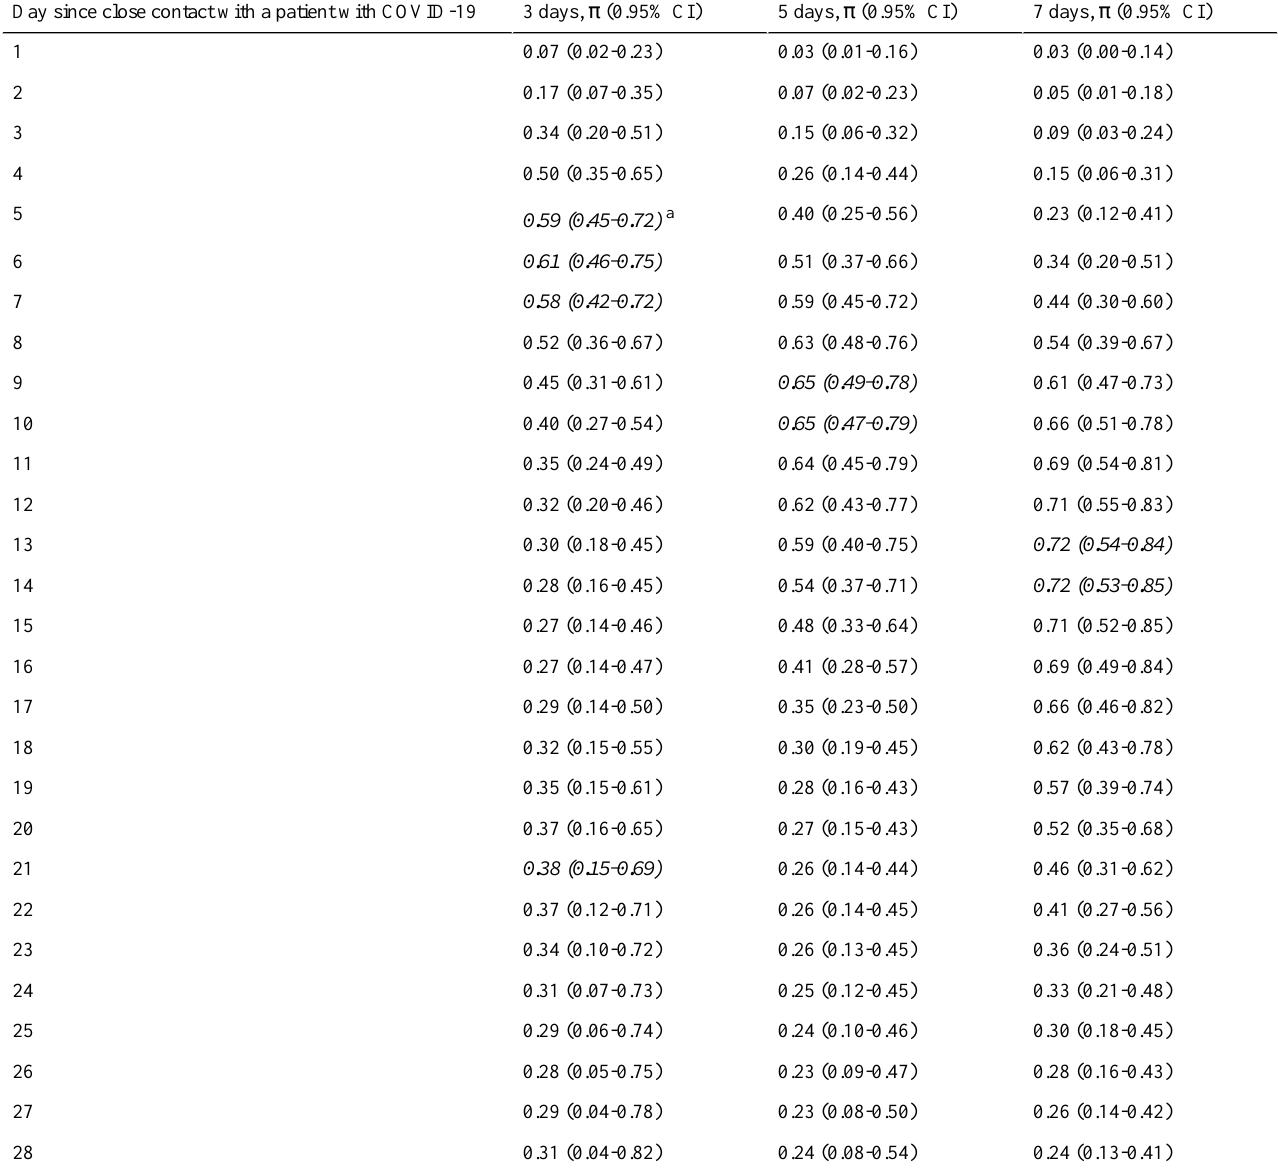
Table 3. Predicted probabilities of the generalized additive mixed model for a positive swab test result for COVID-19 in relation with the number of days since close contact with a patient with COVID-19, among infected health care workers from University Hospital of Verona (Italy) with an initial negative swab test result (the model was fitted with data collected between February 29 and April 17, 2020). Three different scenarios were included for the surveillance time interval (3, 5, and 7